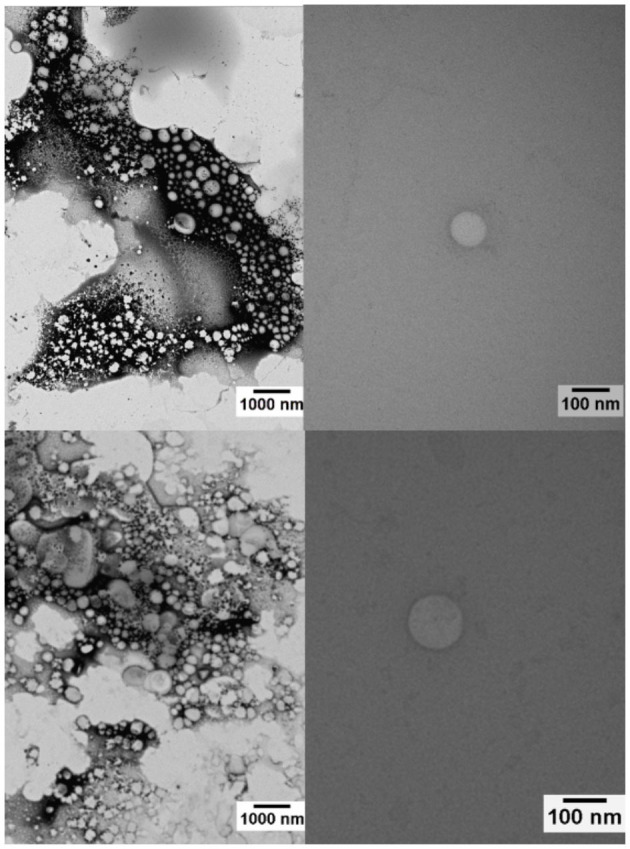
Micrographs of the NE/ALG (top) and NE/ALG-SMT (down) formulations, with magnifications at 10,000 x (left) and 100,000 x (right).